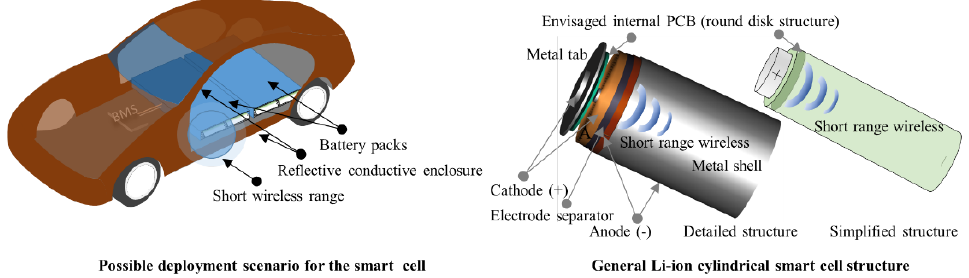
Figure 2. Battery monitoring system (BMS) at cell’s level implementation derived research objec- tives.